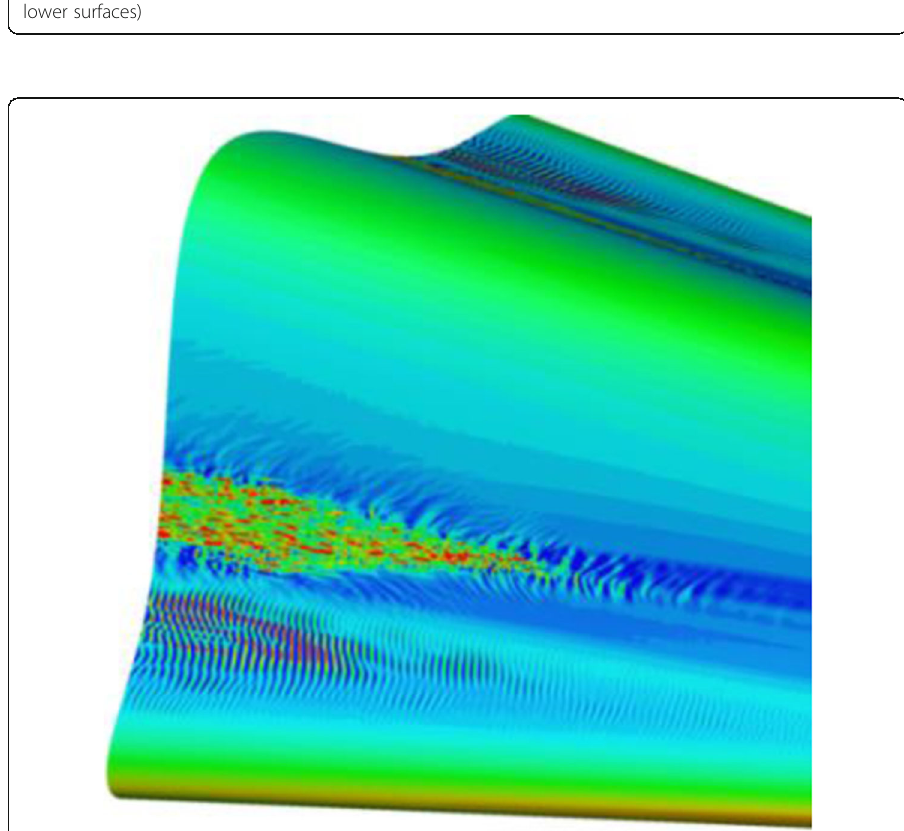
Fig. 7 Friction distribution on the upper surface: a partial enlarged view of the transition